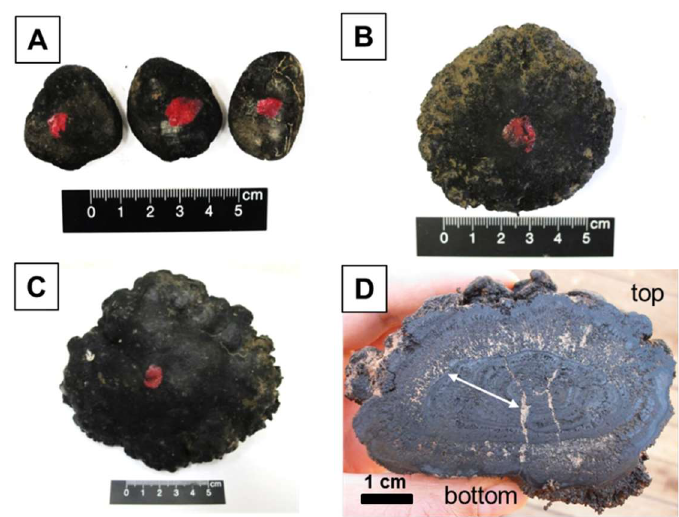
Figure 1. ( A – C ) Small to big nodules (3–>8 cm) with different proportions of hydrogenetic and diagenetic layer growth structures. Small nodules ( A ) are spherical to discoidal with smooth surfaces; Medium to large nodules ( B , C ) have a higher proportion of diagenetic material than the small ones. Those nodules are discoidal to ellipsoidal with a botryoidal rim, which indicates the interface between the upper (smooth) surface, which was in contact with the near bottom water, and the lower (rough) side, which was embedded within the sediment. The red dot marks the nodule’s upper surface during sampling. ( D ) Cross section of a typical large nodule. Dense and porous growth structures alternate with each other through the whole nodule. Pores and cracks are filled with siliceous ooze (marked with white arrow) [5].